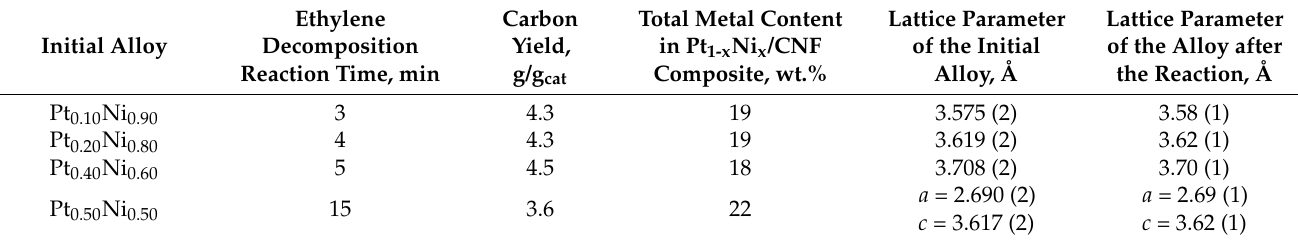
Table 2. Synthesis parameters for Pt 1 − x Ni x /CNF composites and their